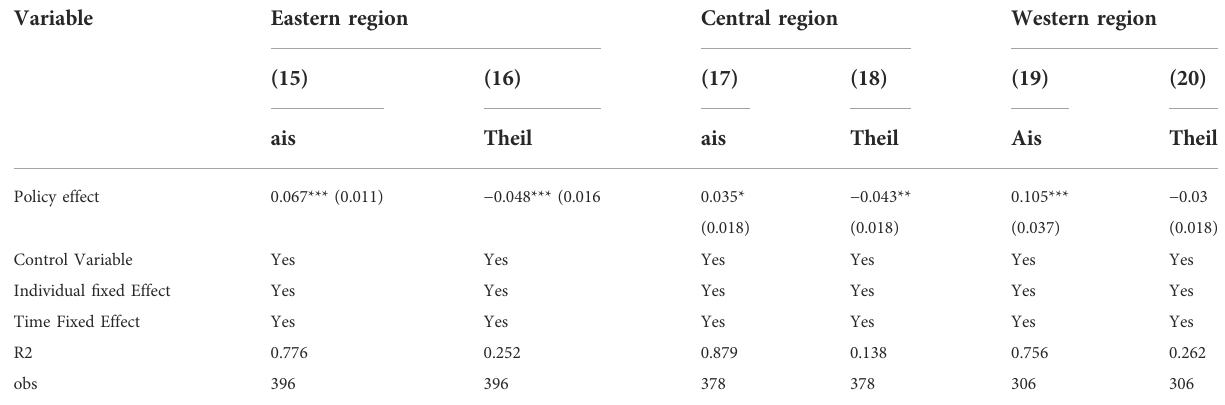
TABLE 7 Regional heterogeneity